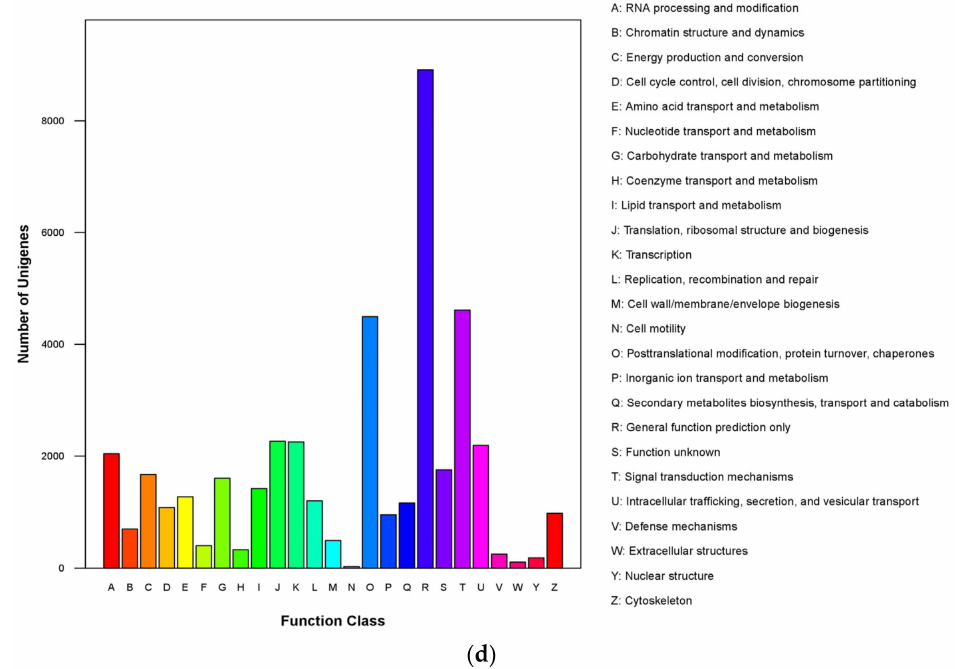
Figure 1. Unigene statistics and annotation. ( a ) The sequence size statistics of unigenes; ( b ) The Venn diagram of unigene annotations from Nr, Swiss-Prot, KOG (Clusters of Orthologous Groups database eukaryote-specific version), and KEGG (Kyoto Encyclopedia of Genes and Genomes) database; ( c ) The top 10 species of BLAST hits of unigenes in Nr database; ( d ) KOG function classification of